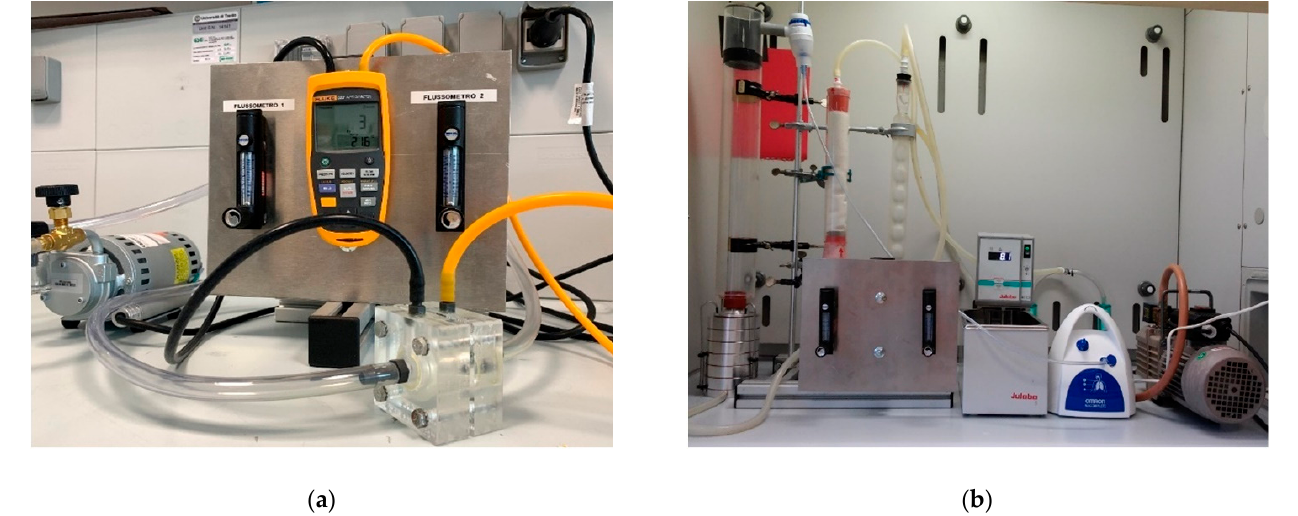
Figure 5. The test system for DP ( a ) and BFE ( b ) at Università di Trento (UNITN). At UNINA, the test rig for DP (Figure 6a) was custom-built using a cylindrical steel reactor in which the sealing cap was replaced with a sample holder. The sample holder, contact with the test cell through a sealing O-ring, the other was threaded and